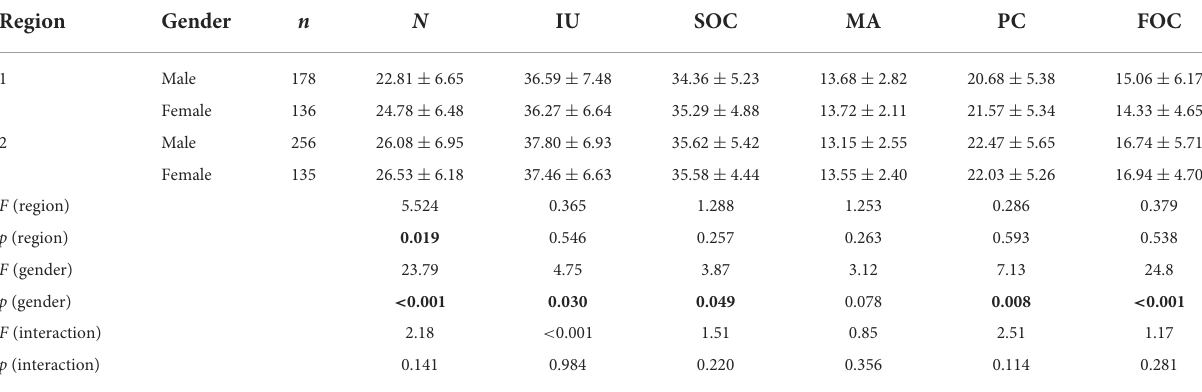
TABLE 1 Description statistics and ANOVA.